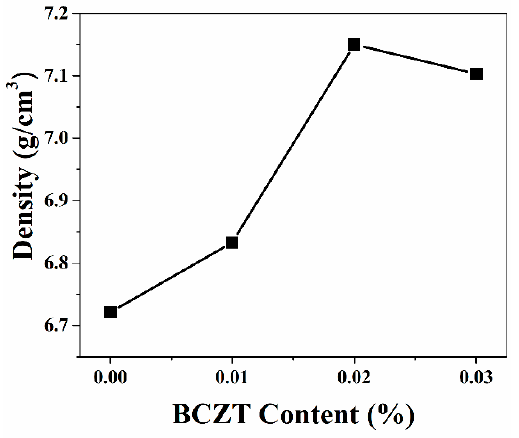
Figure 4. Density measurement of BFBT–zBCZT (z = 0.00–0.030) samples sintered at various temperatures with a soaking time of 2 h at an applied field of 2.5, 3 and 4 kV/cm, which are indicated by blue, black, and red, respectively. Up to a